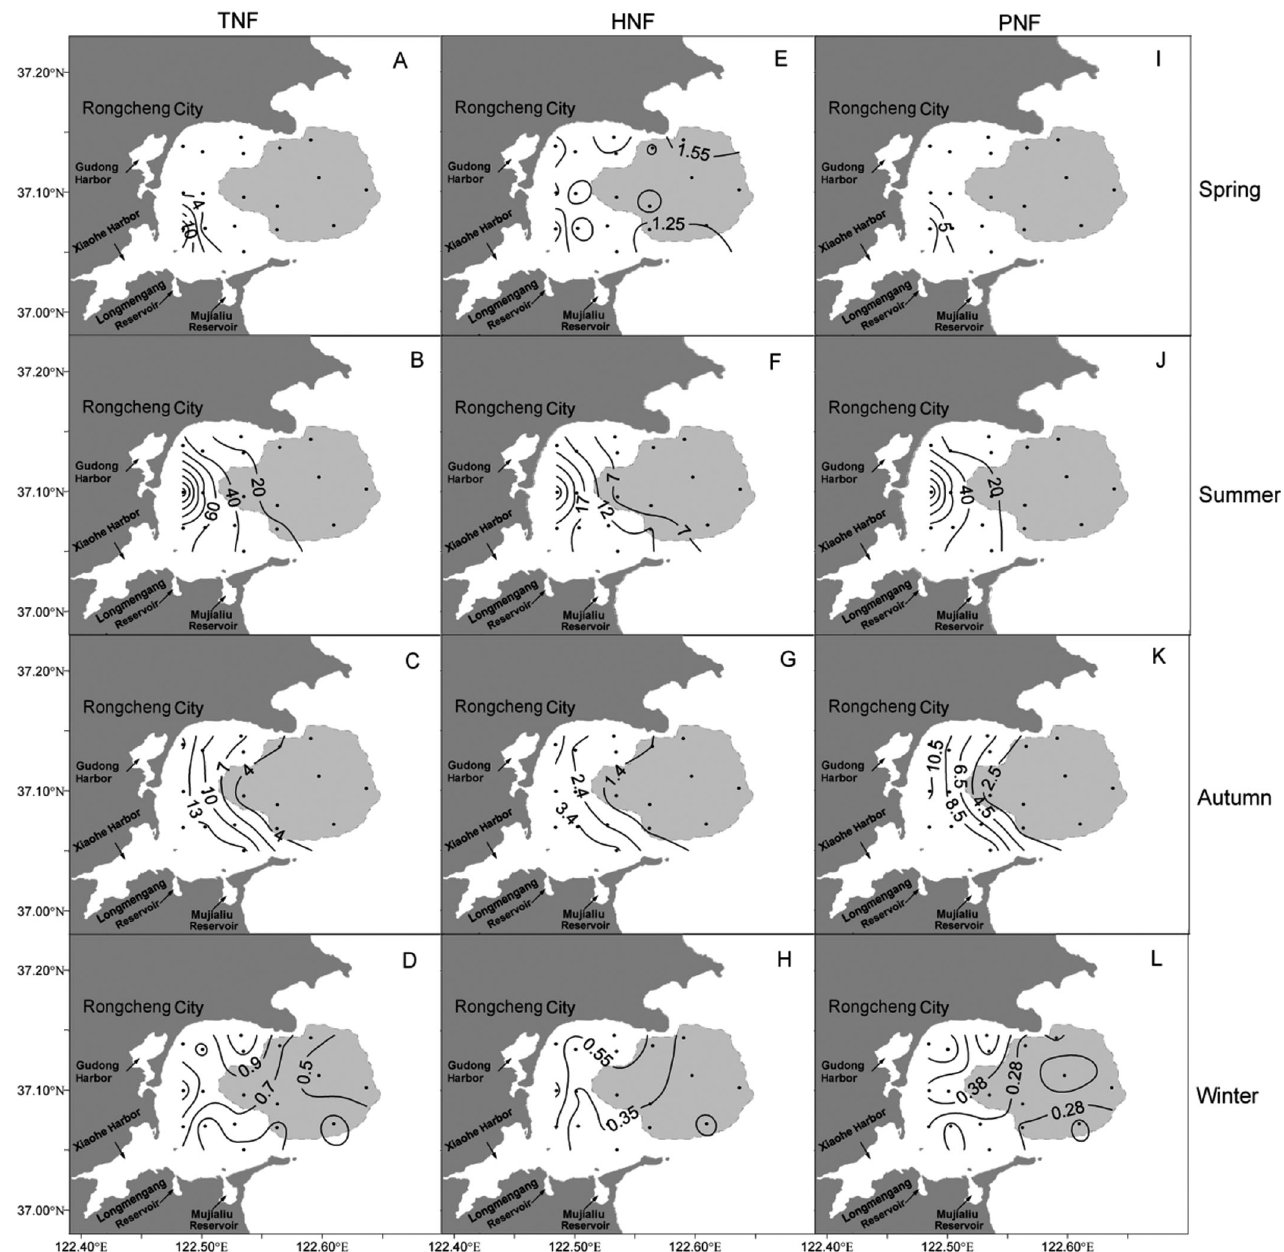
Fig. 3. Spatial variations in (A−D) total nanoflagellate (TNF) abundance, (E−H) heterotrophic nanoflagellate (HNF) abundance and (I−L) pigmented nanoflagellate (PNF) abundance (all: ×10 3 cells ml −1 ) over 4 seasons. Sampling stations, M-area and B-area are marked as in Fig.